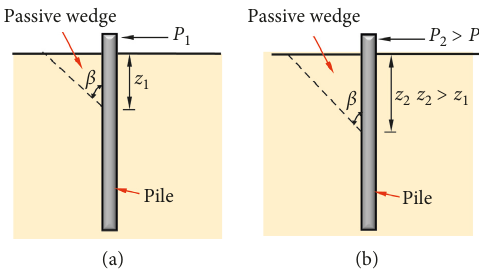
Figure 1: Laterally loaded pile in horizontal ground with different loading: (a) P